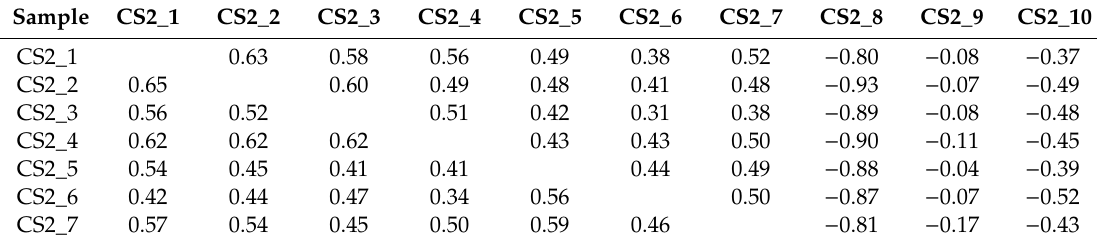
Table 7. Log AR for two-sample comparisons of reference samples from the case study mine site (CS2_1–CS2_7) and two-sample comparisons of samples from other mine sites (CS2_8–CS2_10) and samples from the case study mine site (for details, see